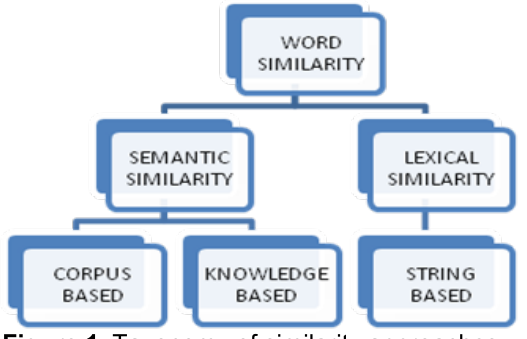
Figure 1. Taxonomy of similarity approaches